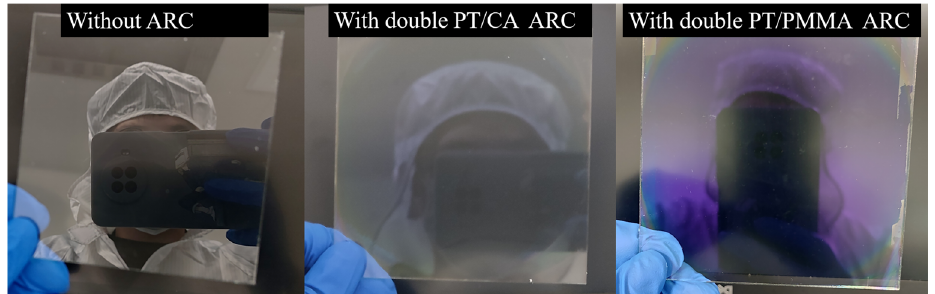
Figure 4. From left to right, the reflection images of the large ‐ area (10 × 10 cm 2 ) bare glass, a large ‐ area and double ‐ sided PT/CA film stack, and a large ‐ area and double ‐ sided PT/PMMA film stack.